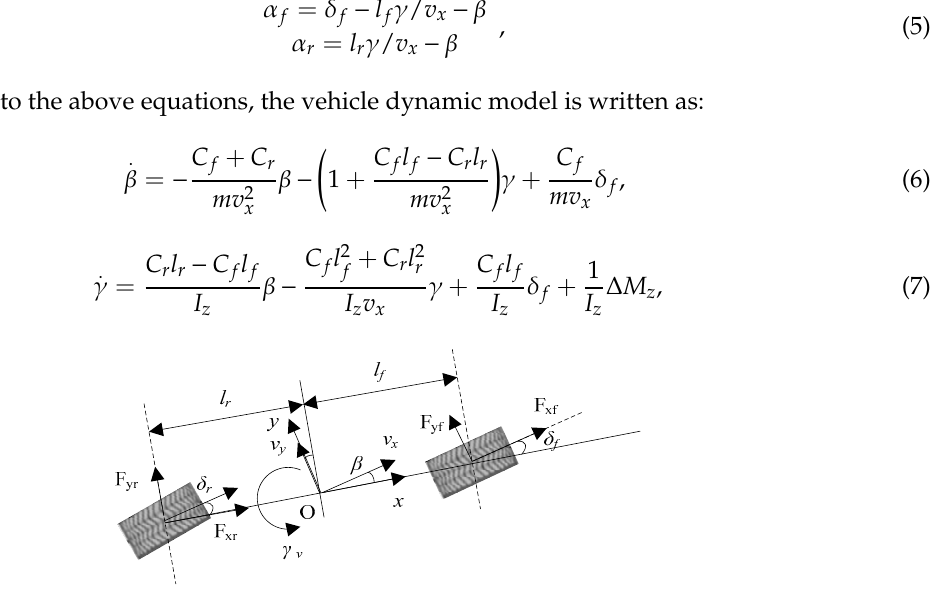
Figure 3. Vehicle dynamic model.